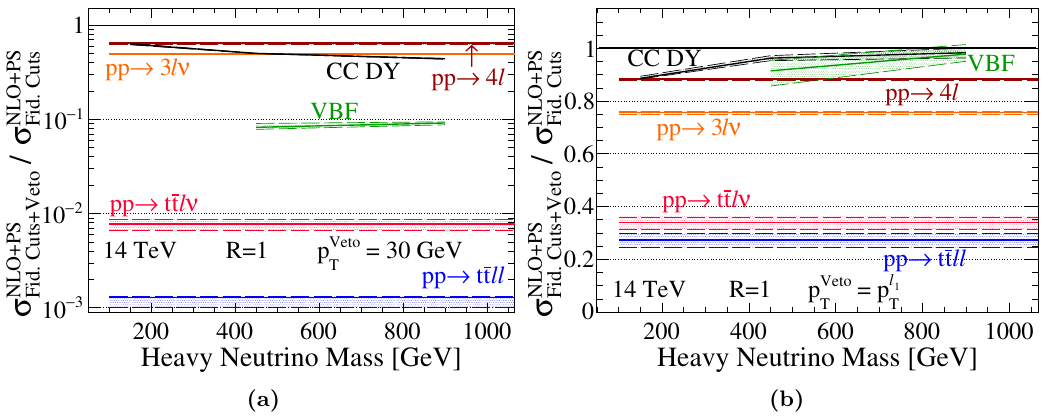
Figure 20. As a function of m N , the NLO+PS jet veto e(cid:14)ciency (relative to the (cid:12)ducial cross section) for the DY and VBF signal processes as well as representative background processes at 14 TeV, assuming (a) a static jet veto of p Veto